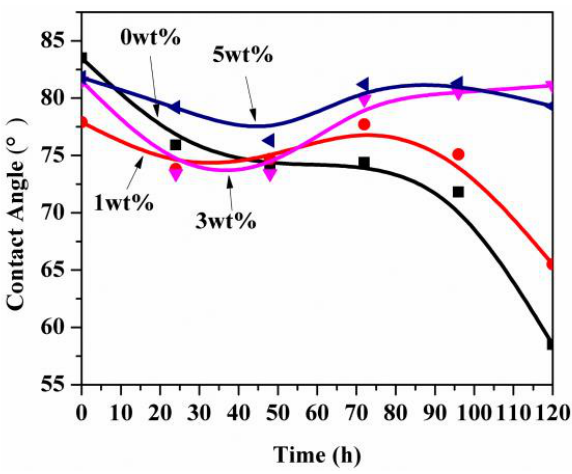
Figure 6. Water contact angles of polyurethane coatings with various SZMO@SG dosages in 5